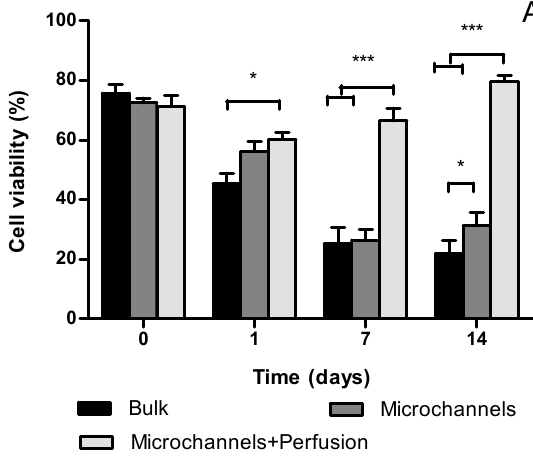
Figure 3. Representative oxygen concentration in the center of a Si-HPMC 2% construct with microchannels seeded with a cell density of 8 million cells/mL and subject to perfusion cycles until recovery of oxygen concentration.